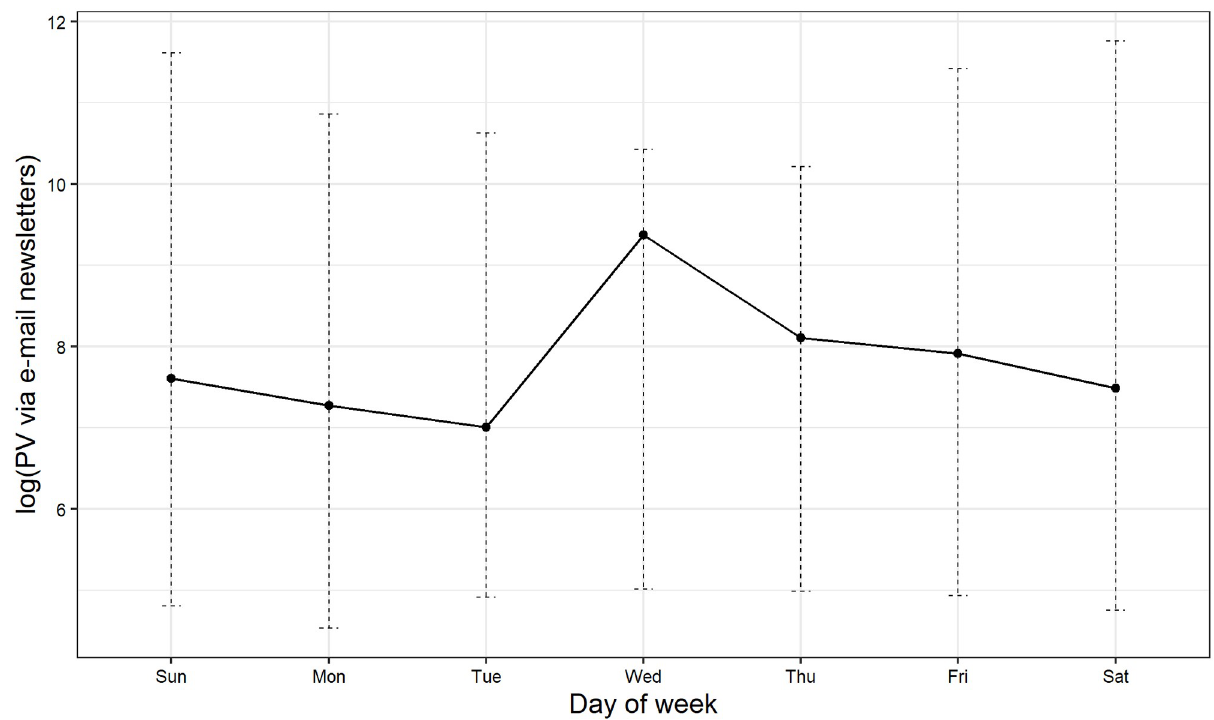
Fig 11. PV via e-mail newsletter by day of week.